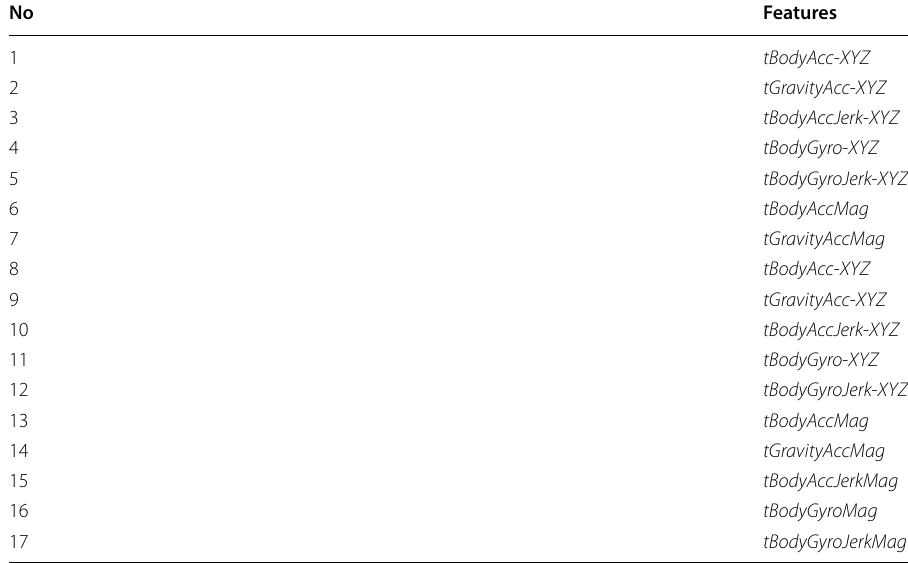
Table 6 Feature description human activity recognition using smartphones dataset (3-axial signal in the X, Y, Z)